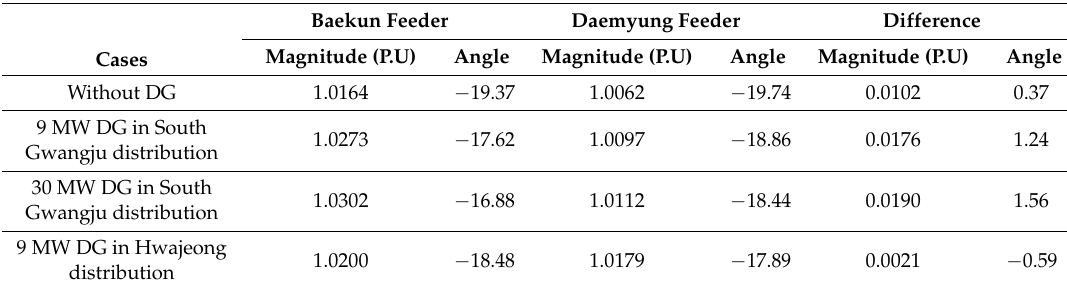
Table 4. Phase angle difference between both ends of switch.